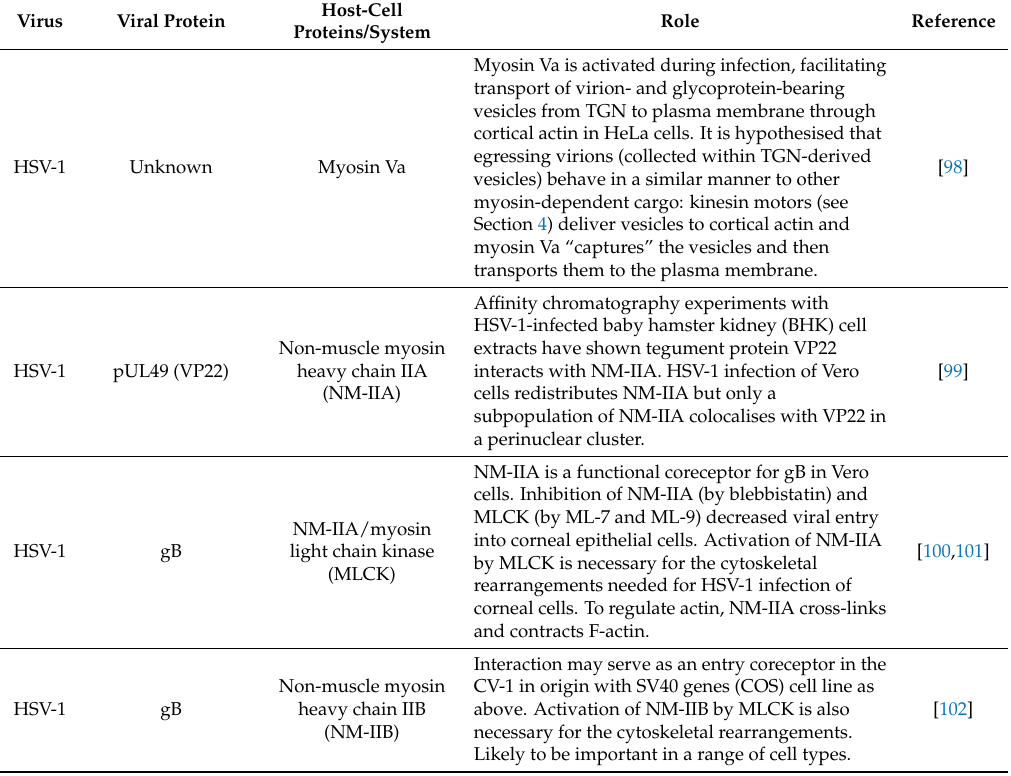
Table 2. Alphaherpesvirus-host interactions that exploit actin-based